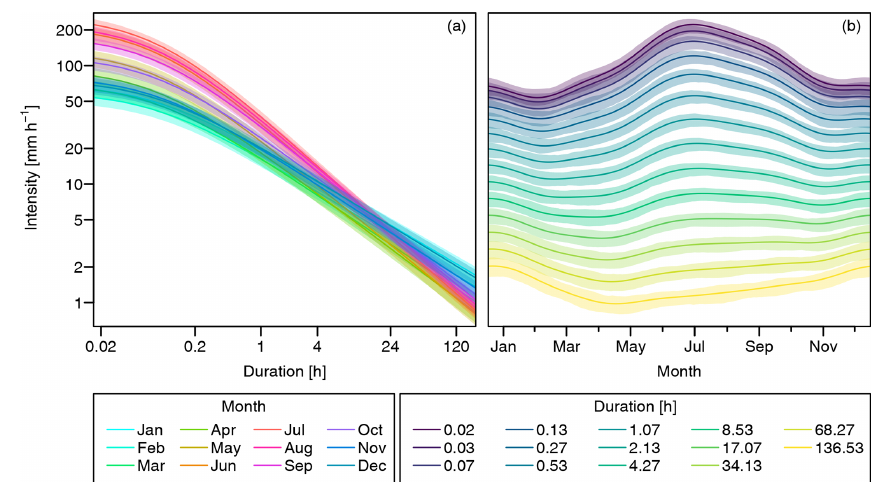
Figure 3. The 0.9 quantiles for station Bever-Talsperre for each month (a) and for various durations (b) . The durations shown correspond to the durations d ∈ 2 { 0 , 1 , 2 ,..., 13 } min discussed in Sect. 2.1. Shaded areas represent the 95% confidence intervals obtained via the bootstrap